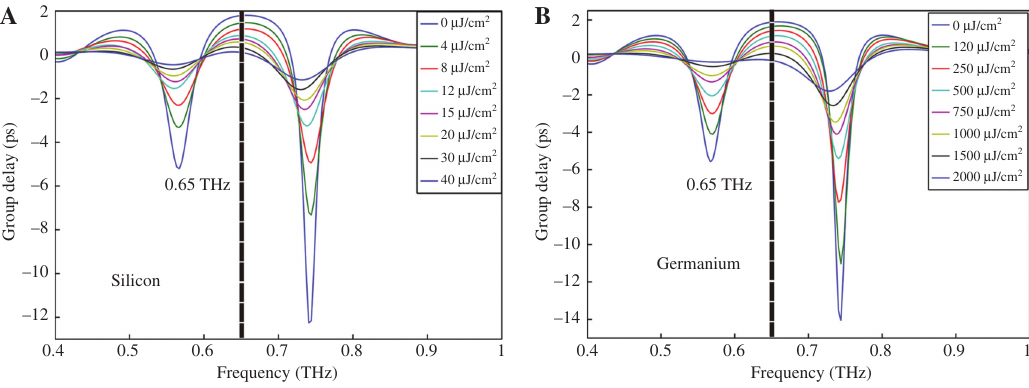
) is used in numerical e-h